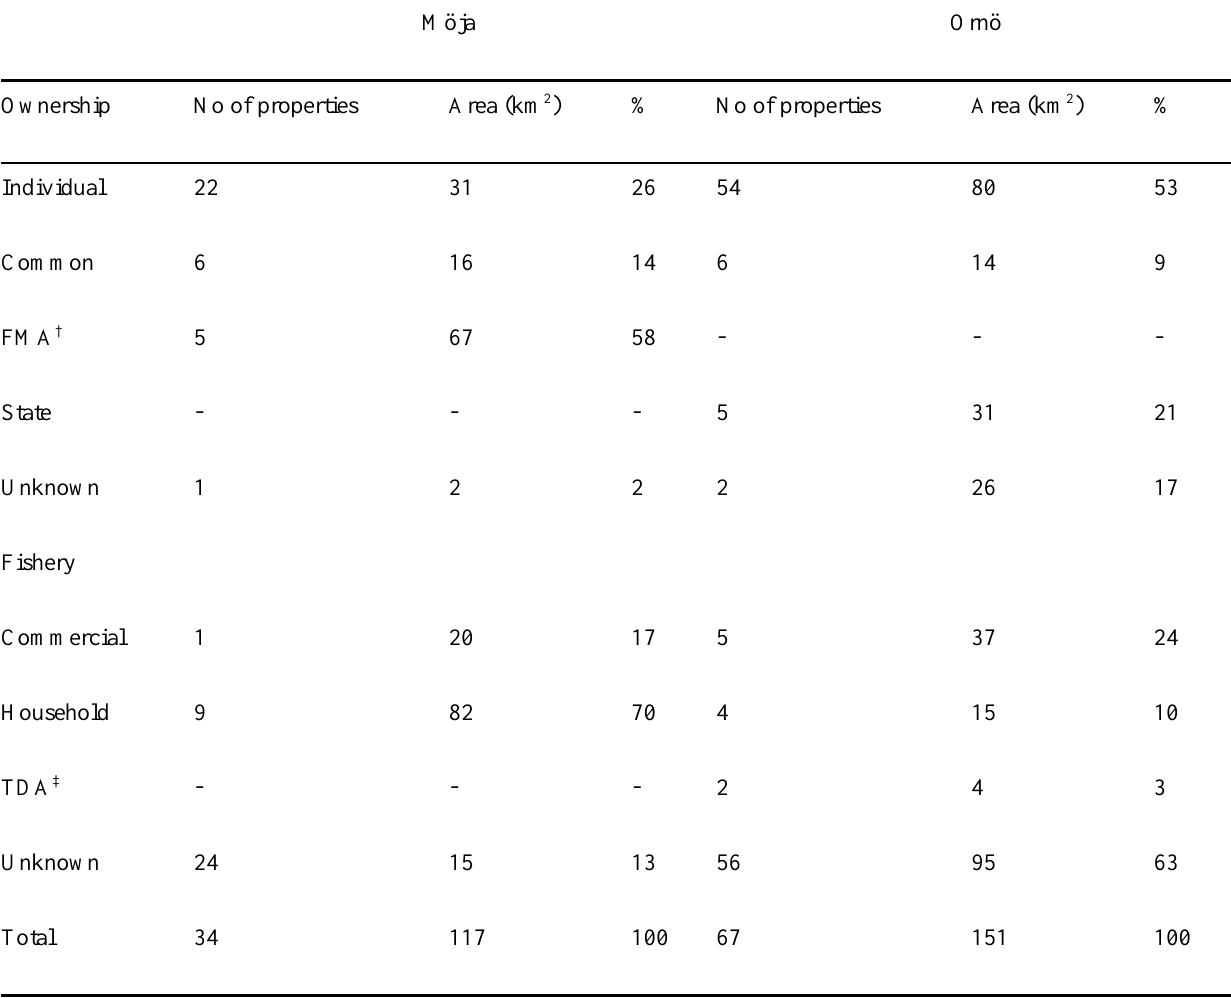
Table 2. Distribution of water ownership and fishery categories in Möja and Ornö parishes, the number of properties within each category, the size and proportion of the total water area. Möja